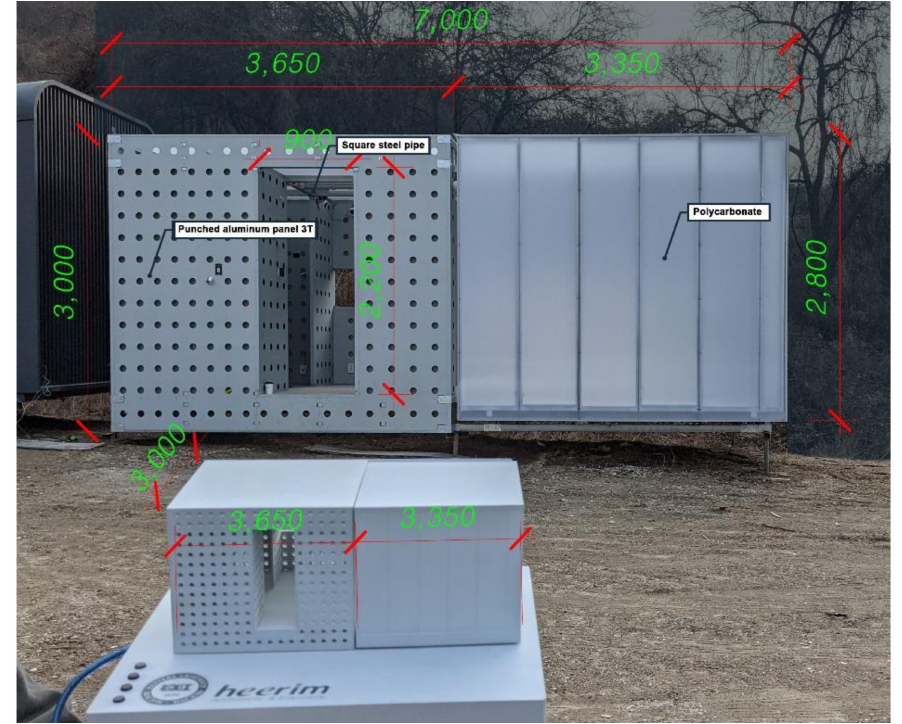
Figure 10. Real-Smart space materials and dimensions.